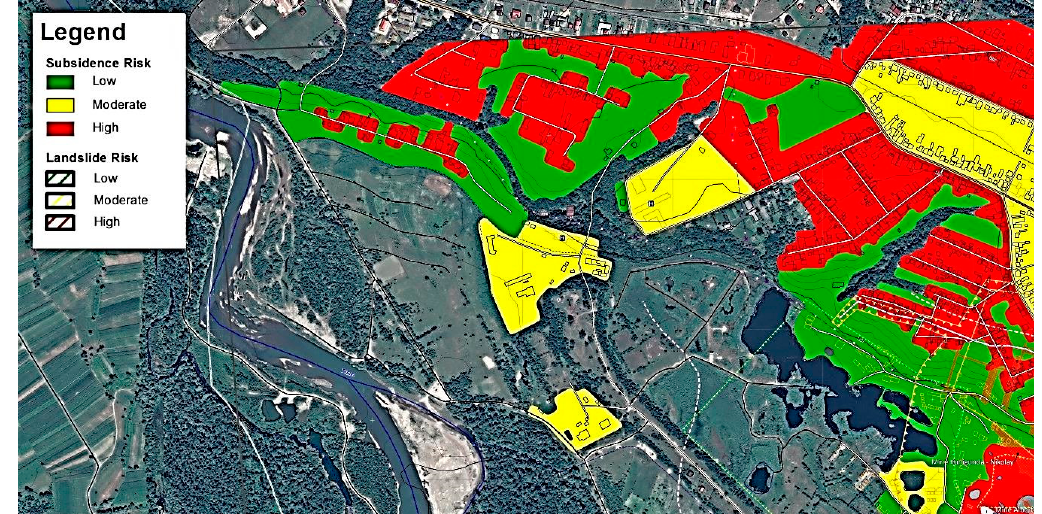
Figure 3. Screenshot of the Copernicus Emergency Management Service 2017 digital map for Solotvyno.